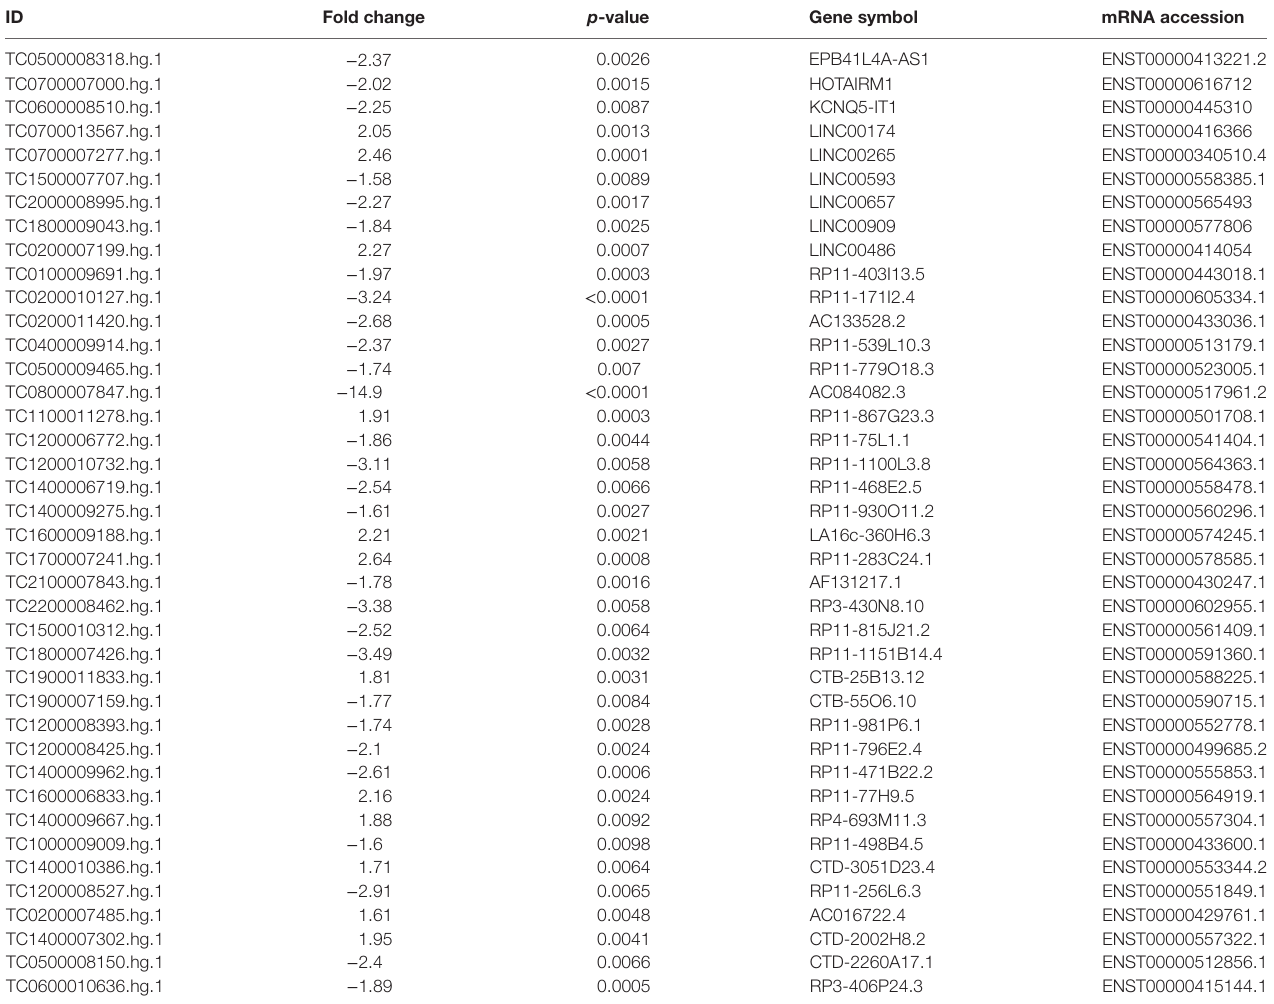
TaBle 1 | Selected modulated long non-coding RNAs in psoriatic arthritis patients versus healthy controls.